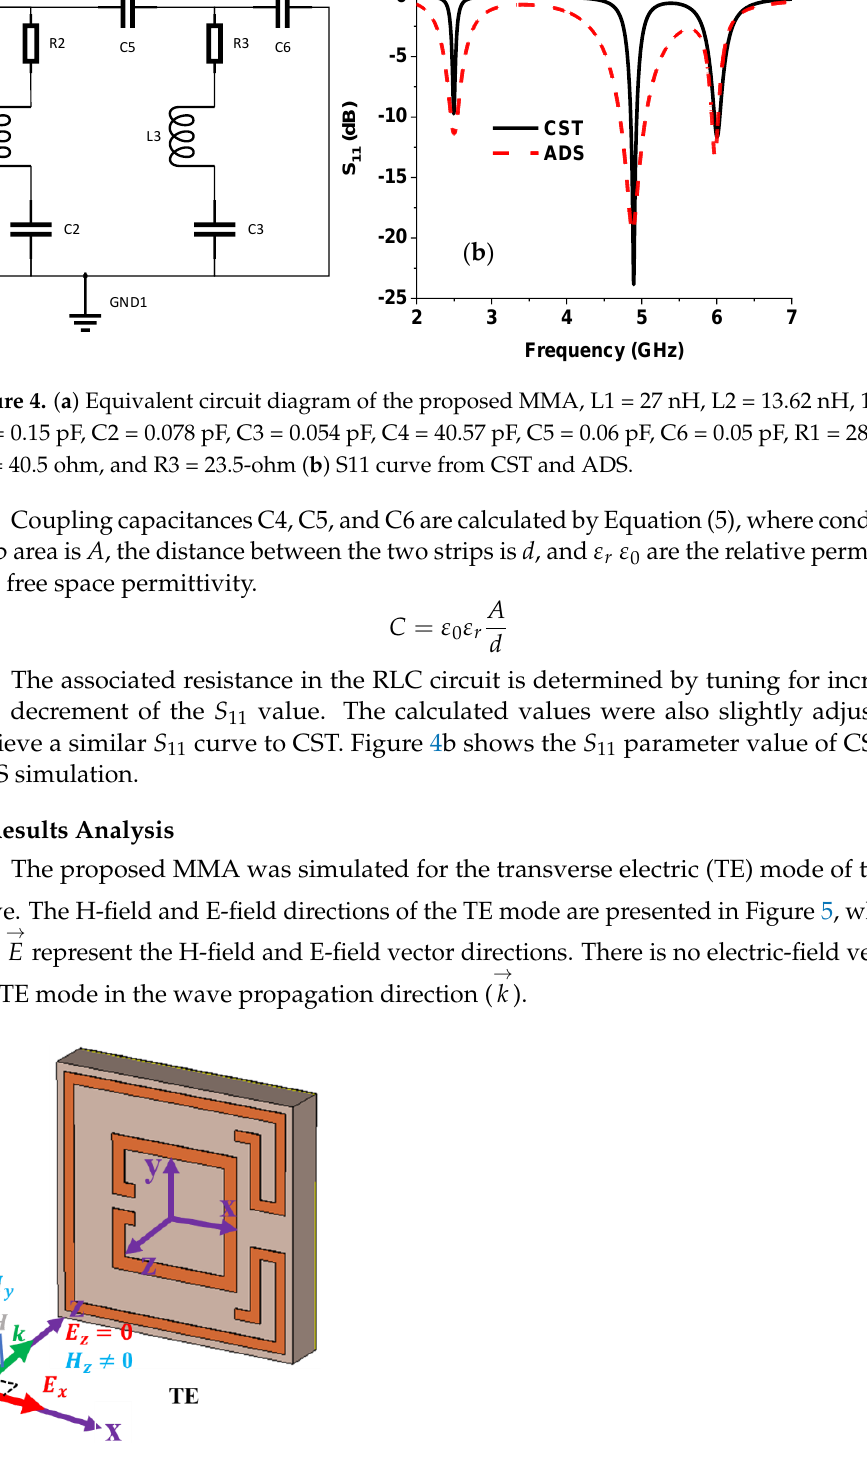
Figure 5. H-field and E-field vector directions for TE-mode incident EM wave.